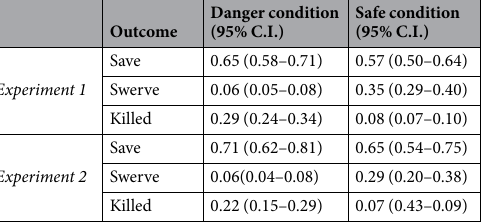
Table 2. Outcomes experienced in each condition (expressed as proportion of total outcomes). C.I.: 95% confidence interval. “Save” refers to the per cent of dogs actively saved by the participant in each condition; this only occurred when the participant exerted sufficient force. Otherwise, the car might swerve (more likely in the safe condition), or it might kill the dog (more likely in the danger condition). Thus, “swerve” refers to the percent of dogs neither killed by the car nor actively saved. “Killed” refers to the percent of dogs killed by the car. Note the similarity in proportions of save/swerve/killed across the long (Experiment 1) and short (Experiment 2) versions of the task. This supports the idea that people choose a ‘golden balance’ level of fatigue which they sustain across the whole block. At that level, their cost of effort matches the average disasters averted for each trial. Note also that the higher effort exerted in the danger condition (see Results section 1) only partially mitigated outcomes in the high danger condition: participants suffered about 25% ‘dog deaths’ in high threat vs. 8% in low-threat. This is what one would expect if participants already operated in the low-threat condition under considerable fatigue. As we can expect cost to be proportional both to effort but also to fatigue (and hence, as fatigue increases with effort, to a power of effort greater than one), balancing losses with fatigue will have a reduced effect in moving from low to high